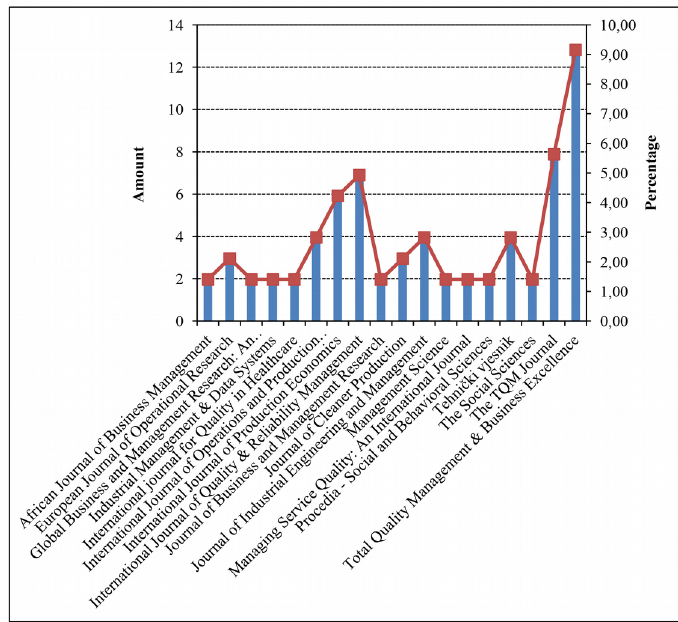
Figure 7. Journals of publication of articles with the topic ISO 9001 QMSC with at least 2 plublished articles